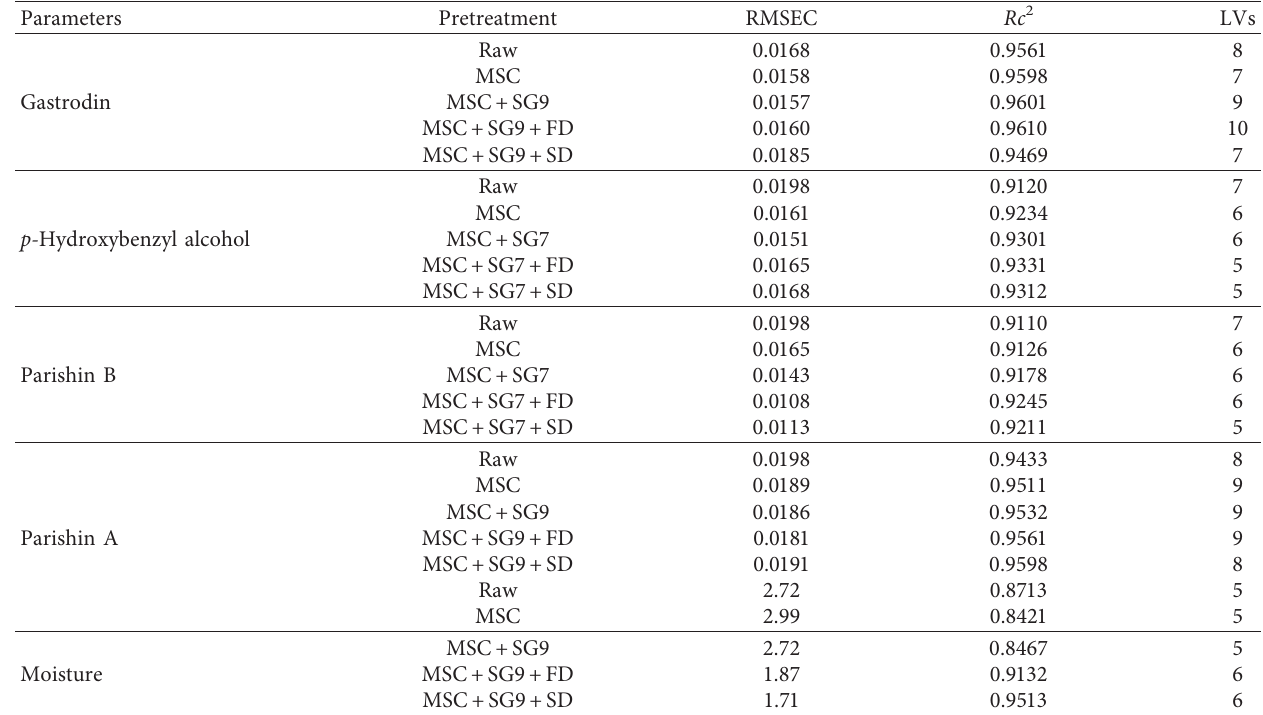
Table 4: Results of different spectral transformation for gastrodin, p- hydroxybenzyl alcohol, parishin A, and parishin B models.